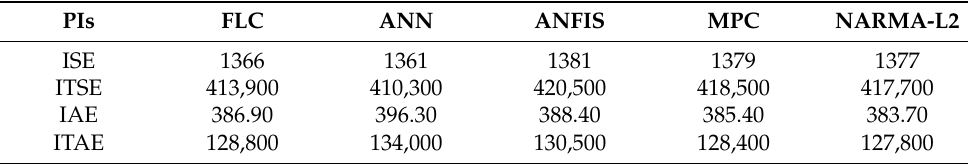
Table 9. Performance indexes for transitory load disturbance.